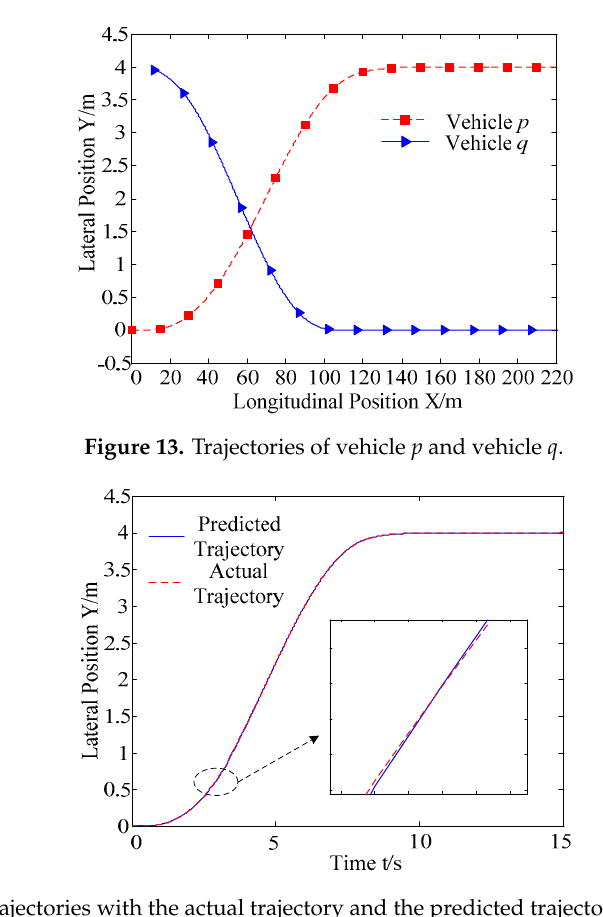
Figure 15. Longitudinal velocity of vehicle p . f δ Figure 16. Front wheel steering angle of vehicle p . Figure 17. Yaw angle of vehicle p .